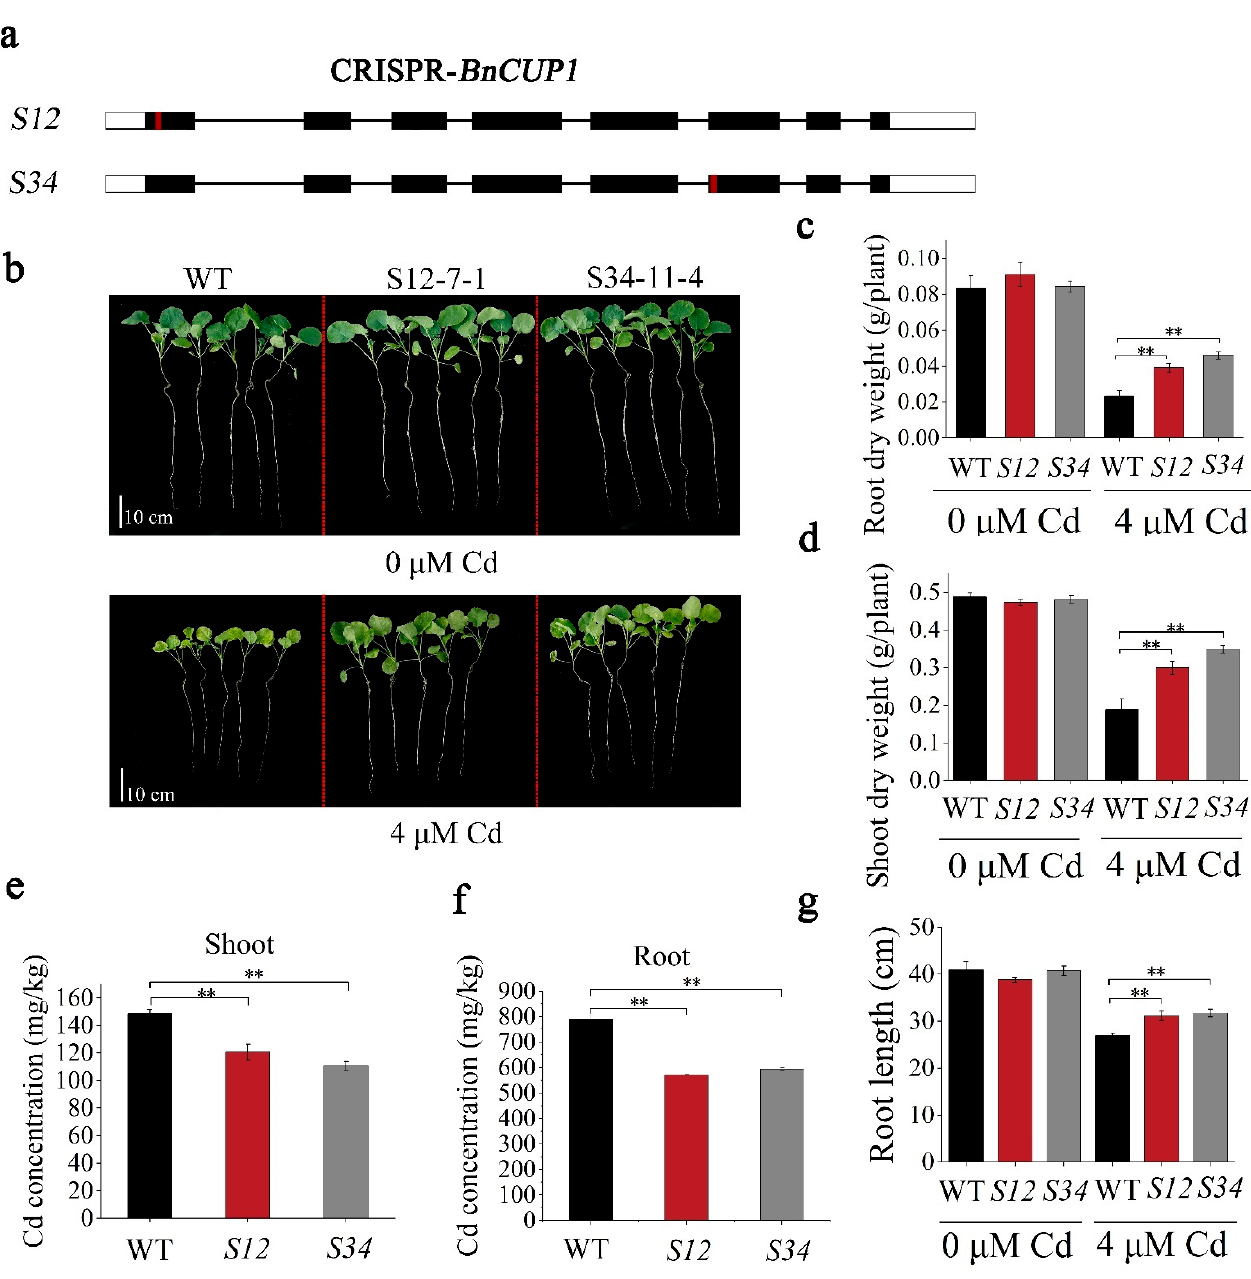
Figure 5. BnCUP1 -edited B. napus reduced Cd accumulation. ( a ) Schematic diagram of two CRISPR- BnCUP1 lines. The black rectangle shows the exon of BnCUP1 , the straight line marks the intron of BnCUP1 , and the red box indicates the location of the sgRNA. ( b ) Growth of two CRISPR-BnCUP1 lines ( S12 and S34 ) cultured in hydroponic solution containing 0 or 4 µ M Cd for 20 days. ( c , d ) Dry weight of WT, S12 lines and S34 lines in roots and shoots, respectively. ( e , f ) Cd concentration of WT, S12 lines and S34 lines in roots and shoots, respectively. ( g ) Root length of WT, S12 lines and S34 lines, respectively. All experiments were independently repeated at least three times. The error bar represents standard deviation. Statistical analysis was performed by Student’s t- test (** p < 0.01). In order to test whether the CRISPR-BnCUP1 lines reduced Cd uptake, 2-week-old seedlings ( S12 / S34 /WT) were cultured with nutrient solution, with or without 4 μ M Cd,